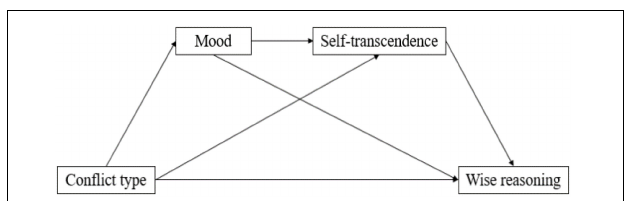
FIGURE 1 | Hypothesized